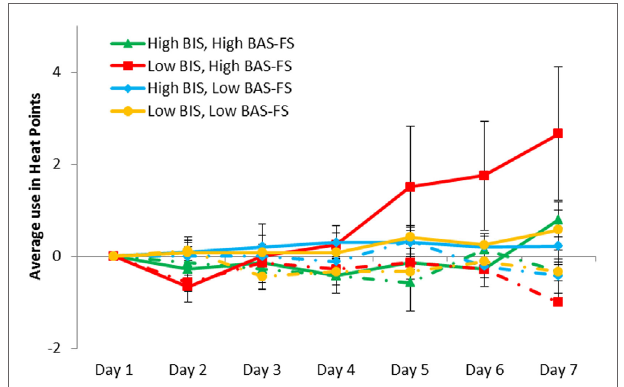
FigUre 2 | average use of energy on each day of the week grouped by condition (unfair versus fair) and four different combinations of low and high scores on Bis and Bas-Fs: (1) high Bas-Fs and high Bis; (2) high Bas-Fs and low Bis; (3) low Bas-Fs and high Bis; (4) low Bas-Fs and low Bis . Error bars represent SE of the mean. The scores are corrected for the baseline use in the first day. High/low groups are identified based on above/below the mean of a respective scale. Dotted lines represent fair, and solid – unfair